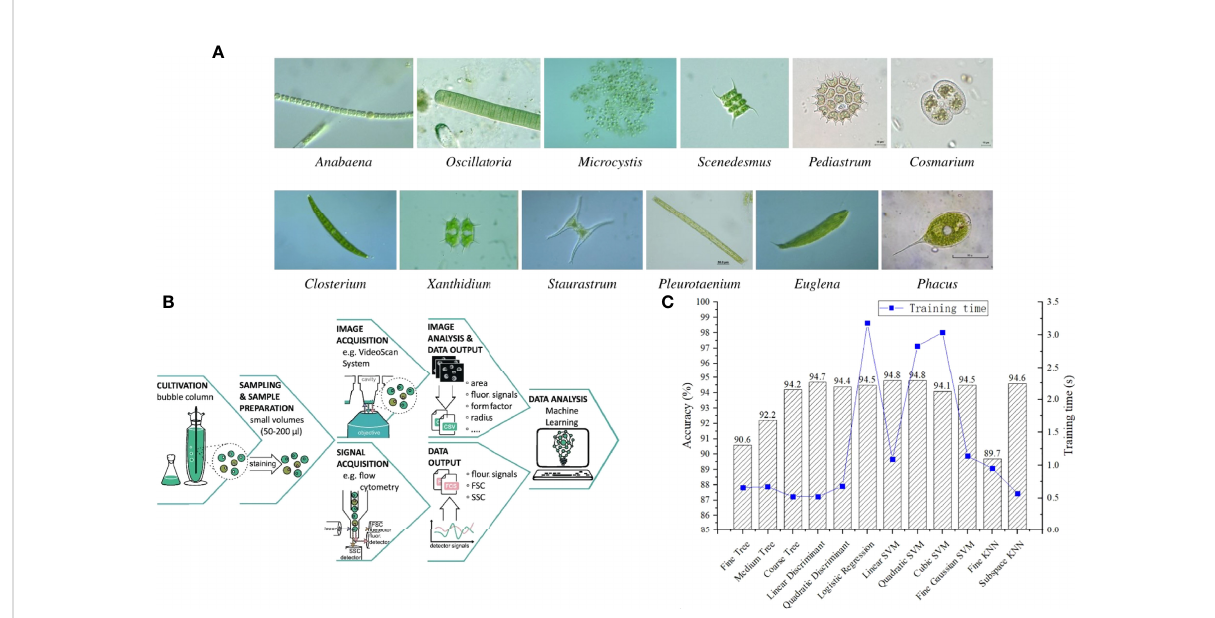
FIGURE 5 (A) Images of twelve species ofmicroalgae.(reproduced with permission fromPromdaen et al., 2014). (B) Procedureofmicroalgae classi fi cationand recognition based onmachine learning.(reproduced with permission fromReimann et al., 2020). (C) Procedureof microalgae classi fi cationand recognition based onmachine learning.(reproduced with permission fromWanget al.,